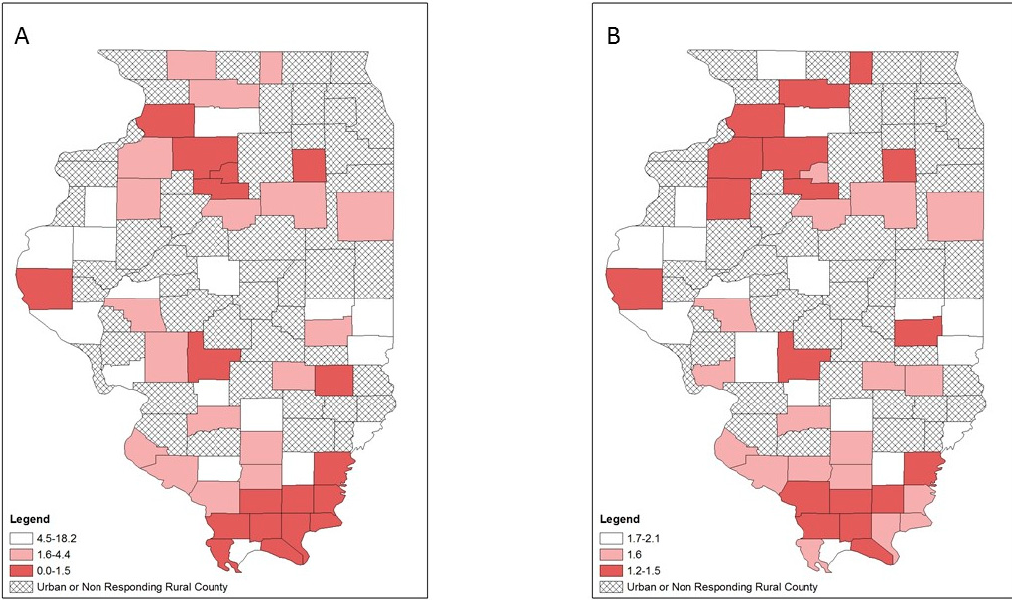
Figure 3. HIV prevention and treatment services at local health department services per 100,000 population by tertiles, respondent rural counties, Illinois, 2018: ( A ) crude rates; ( B ) empirical Bayes estimated rates.